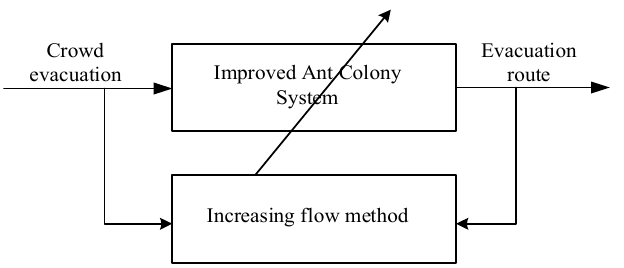
Figure 4. Improved ant colony system ( IACS) for a dense crowd evacuation solution.